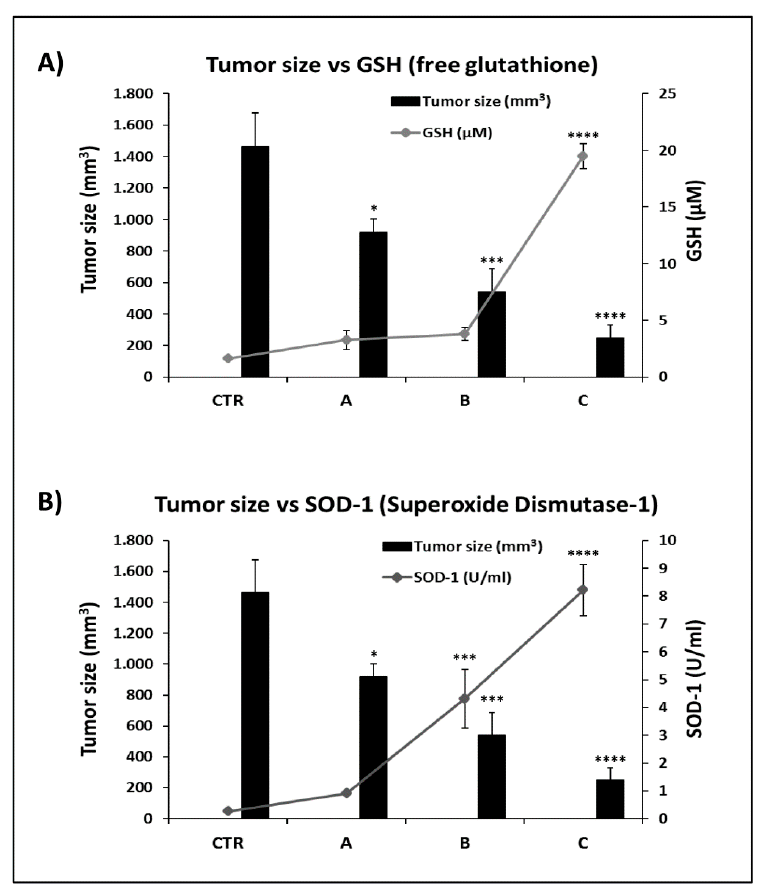
Figure 6. FPP ® antioxidant effect by measuring the plasma antioxidant levels (GSH and SOD-1). Analysis of the total plasma antioxidant activity (glutathione GSH and superoxide dismutase SOD-1) taken before the sacrifice of the control mice (untreated) and mice treated daily with FPP ® starting at 21 days before (group A), 14 days before (group B) and 3 days before (group C) the inoculation up to the sacrifice. Mice were treated only sublingually with FPP ® at the concentration of 200 mg/Kg/mouse every day without interruption until the sacrifice of the animals. ( A ) Comparison between tumor size and GSH activity in control mice group and in mice groups treated with 200 mg/Kg/day of FPP ® (groups A, B, C). Analysis of the quantification and detection of GSH activity ( µ M) was conducted by a colorimetric activity assay the concentration was determined by measuring the absorbance at 405 nm. ( B ) Comparison between tumor size and SOD-1 activity in control mice group and in mice groups treated with 200 mg/Kg/day of FPP ® (groups A, B, C). Analysis of the quantification and detection of SOD-1 activity (U/mL) was conducted by a colorimetric activity assay and the absorbance was read at 450 nm. Data are expressed as means ± SE. * p < 0.05, *** p < 0.001, **** p < 0.0001.